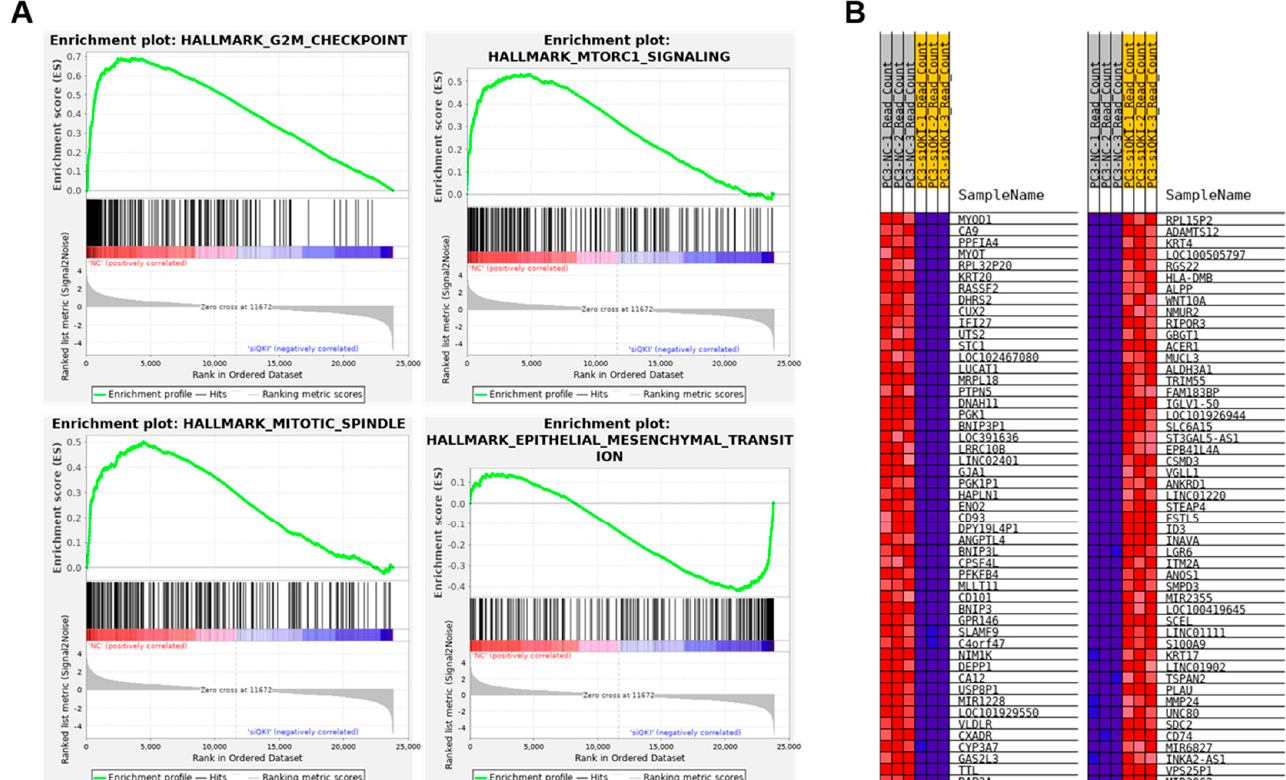
Figure 4. RNA-sequencing and gene-set enrichment analysis of QKI-knockdown PCa cell. ( A ) Enrichment plots of selected hallmark gene-sets. G2M_checkpoint, MTOR2_siganling and Mitotic_spindle gene-set enrichment plots show enrichement in NC (negative control) siRNA samples. Epithelial_mesenchymal_transition gene-set enrichment plot do not show significant enrichment. ( B ) Heatmap correlation plots of signature genes in PC3-NC sample vs PC3 siQKI (siRNA knockdown of QKI gene) sample. Top positive/negative genes are shown.